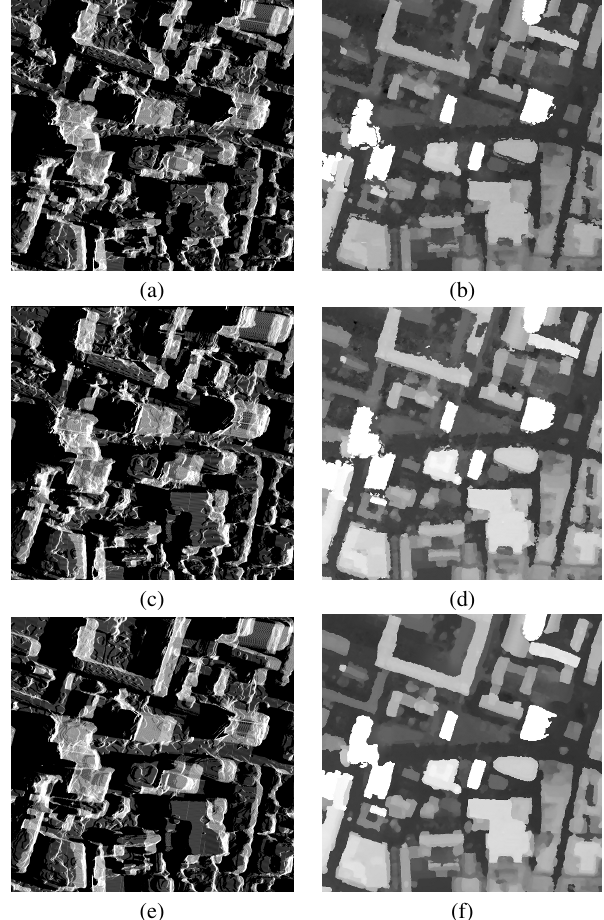
Figure 7. Impact of DSM quality on simulated SAR images; scene: Barbican, London. The DSMs have been generated from different sets of optical images; (a, c, e) simulated SAR images; (b, d, f) DSMs derived from 2, 3, and 5 WorldView-2 images; acquisition date of TerraSAR-X image: November 1st,